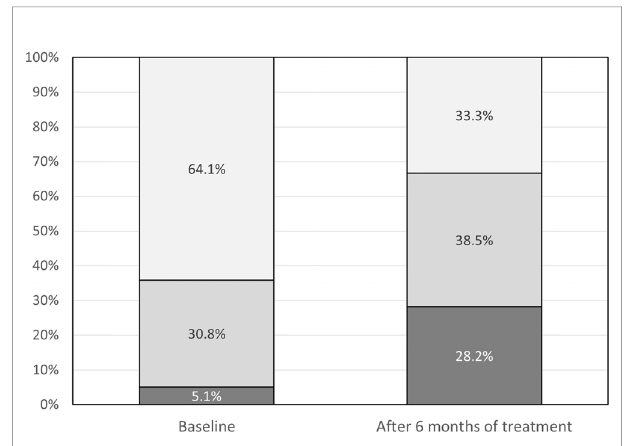
FIGURE 3 | Antihyperglycemic treatment at baseline and after 6 months of treatment: dark grey – metformin and other drugs, medium gray – metformin only, light gray – diet only.